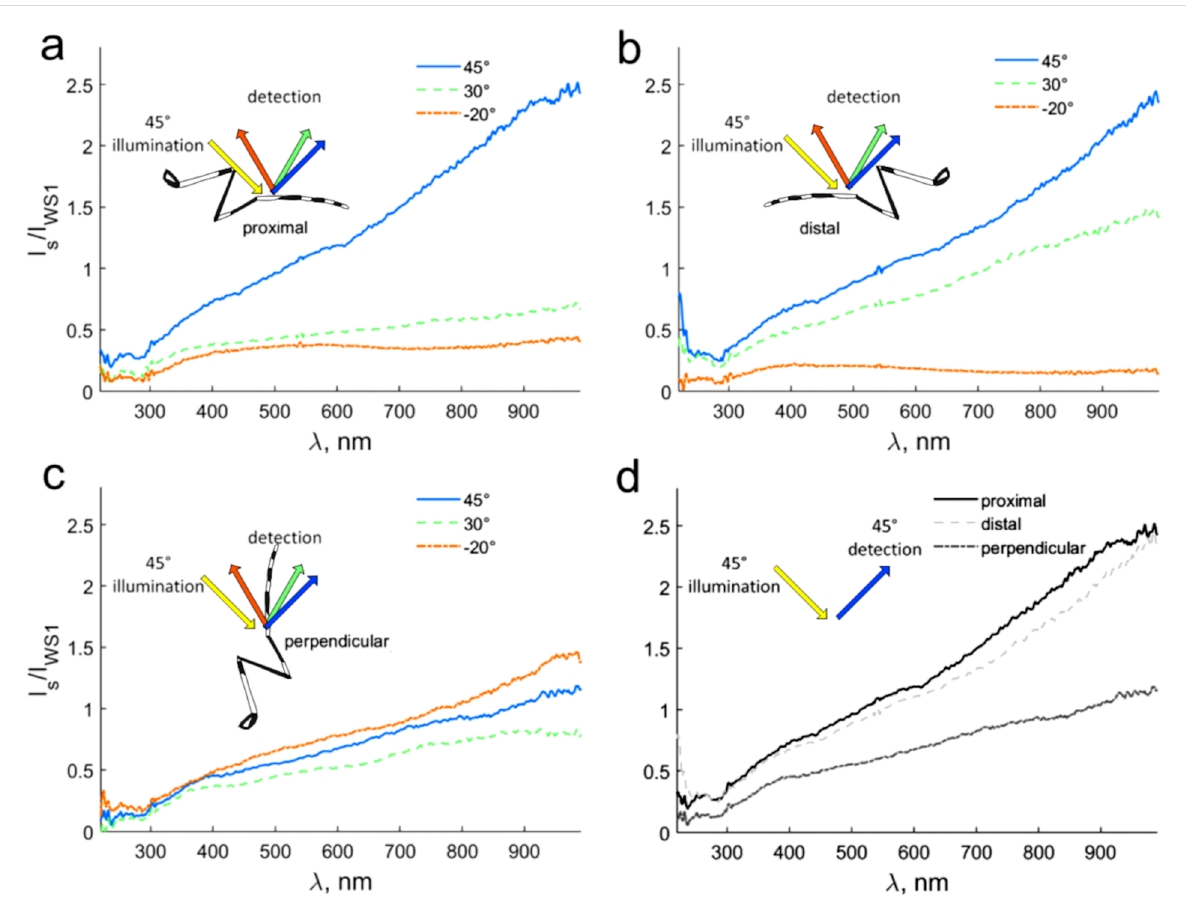
Figure 6: The light scattering spectra from a white area of the hindleg tarsus of Aedes albopictus male at different leg orientations. The white spot was illuminated at 45°. The light scattering was detected at 45°, 30°, and − 20° (relative to the normal to the surface). Illumination was performed at differ- ent leg orientation relative to the illumination source: illumination was from the proximal direction (a), from the distal direction (b), and perpendicular to the tarsus main axis (c). Reflection at 45° for different leg orientations is summarized in